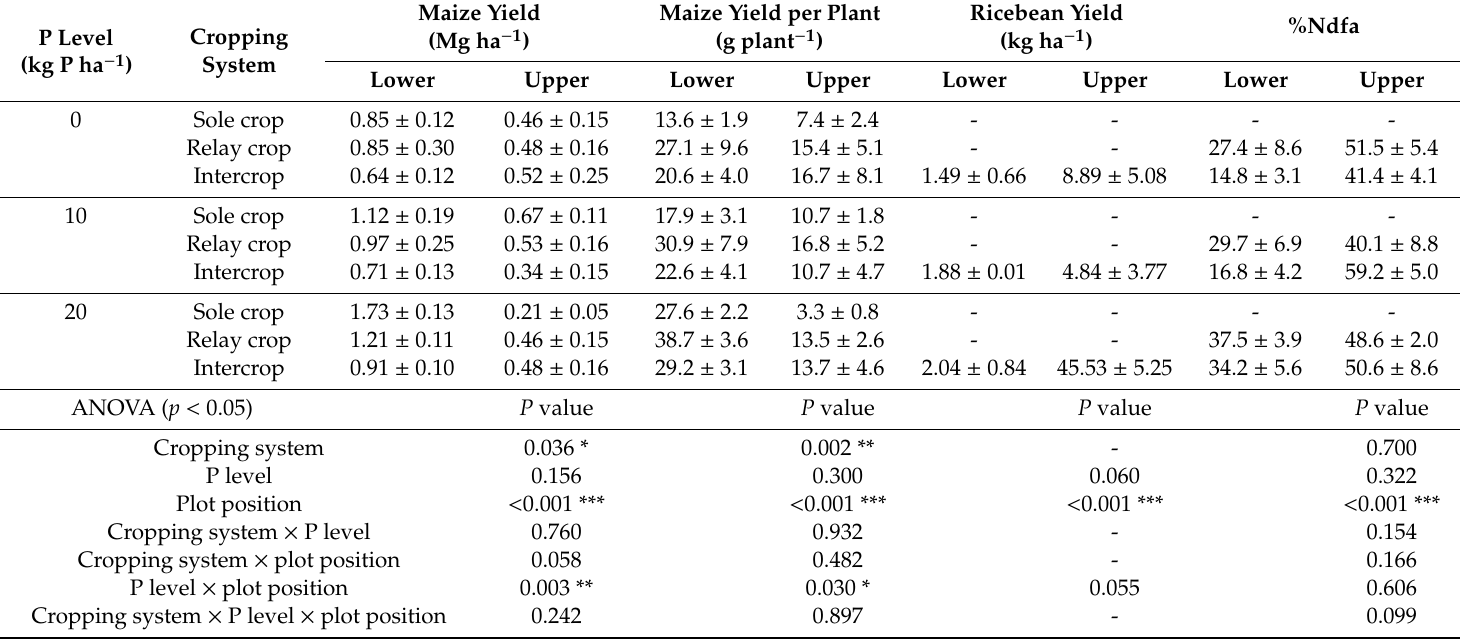
Table 4. Maize yield, maize yield per plant, ricebean yield and percentage of nitrogen derived from the atmosphere (%Ndfa) (mean ± standard error), and the results of three-way analyses of variance (ANOVA) at the lower and upper plots of the researcher-managed field